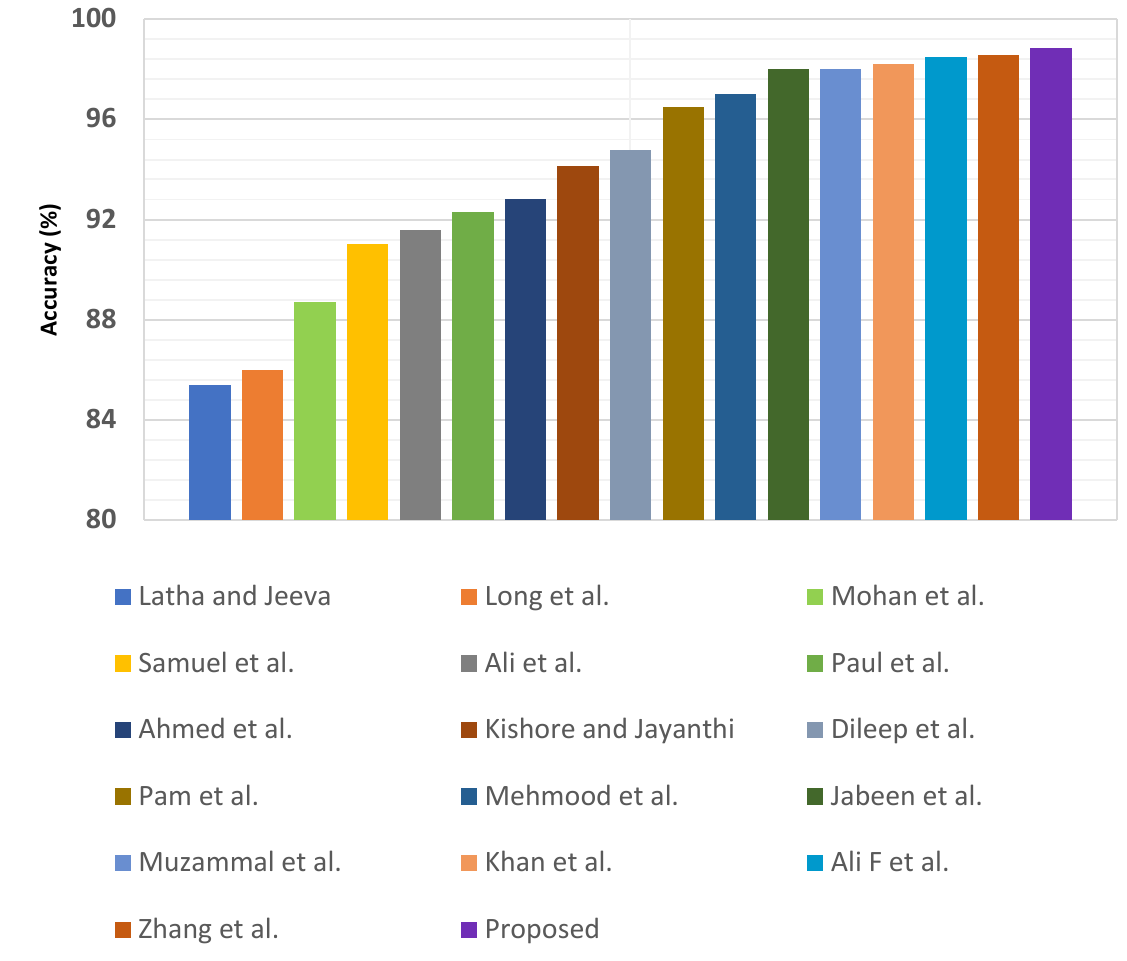
Figure 11. Comparison with state-of-the-art systems.